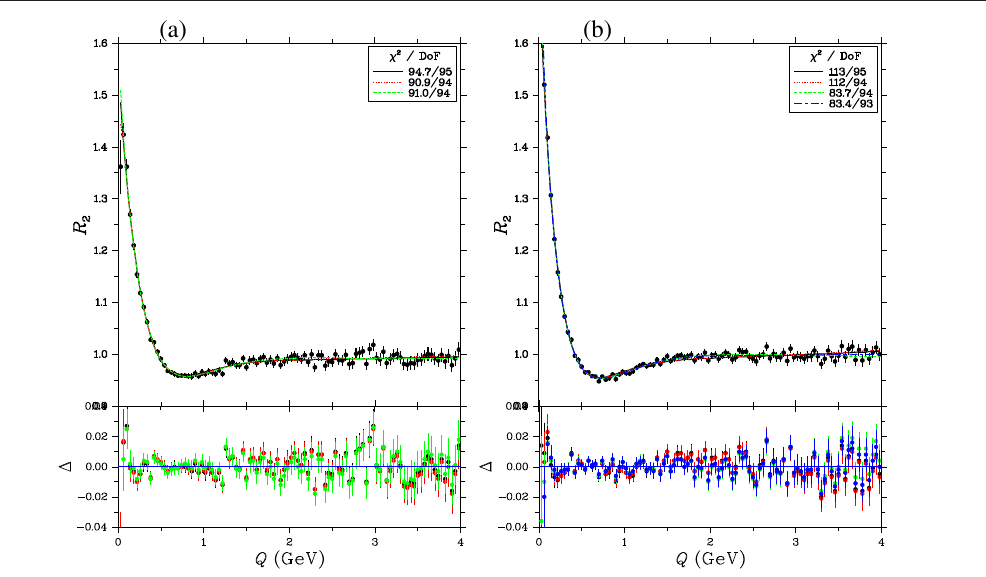
Figure 4. (a) Fits of the τ -model (black), the order-1 expansion of the τ -model (red), and the τ -model with R a free (green), for two-jet events; (b) Fits of the τ -model (black), the order-1 expansion of the τ -model (red), the τ -model with R a free (green), and the order-1 expansion of the τ -model with R a free (blue), for three-jet